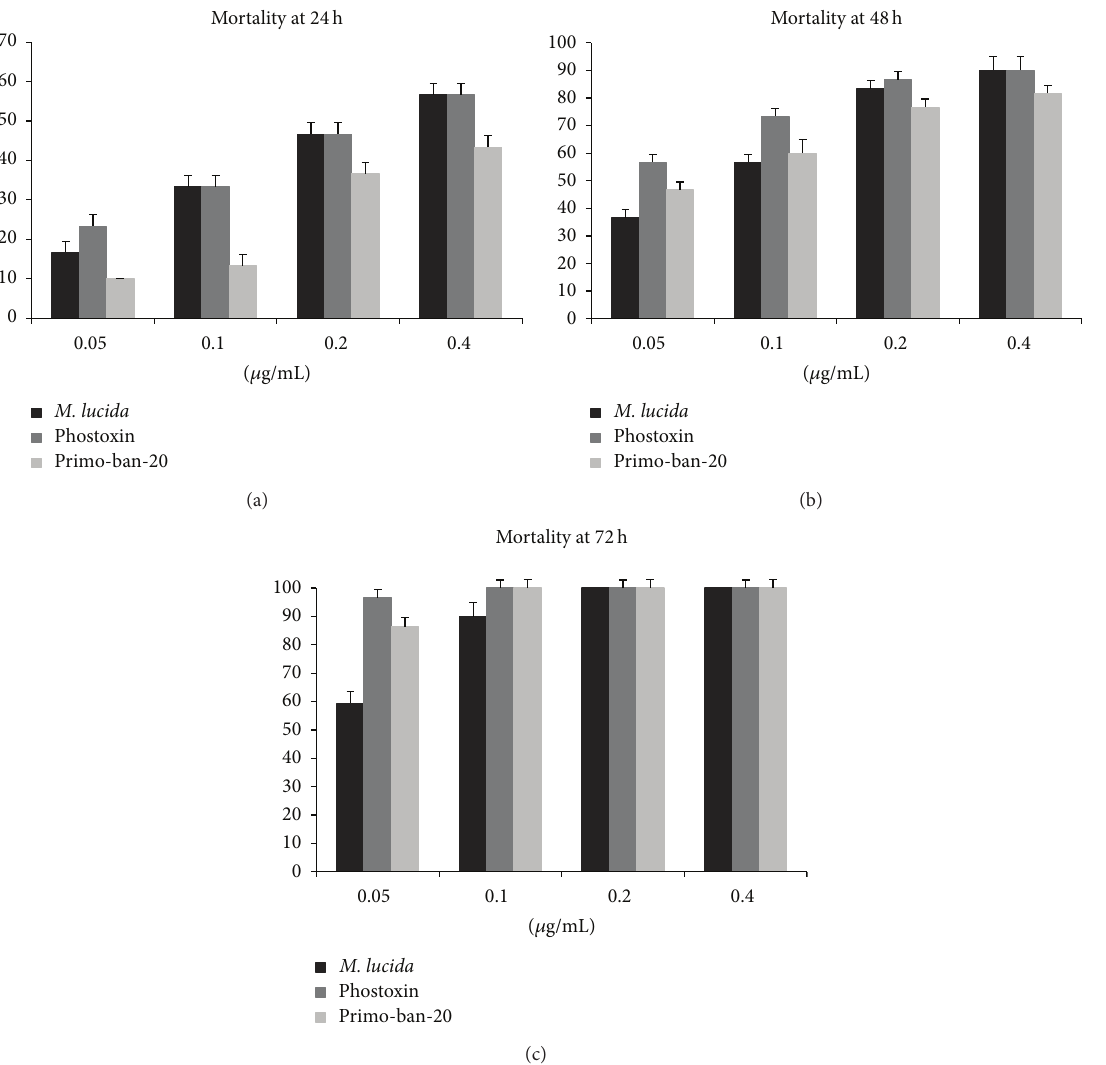
Figure 1: Effect of the Morinda lucida essential oil and pesticides against Callosobruchus maculatus at different concentrations and exposure times.